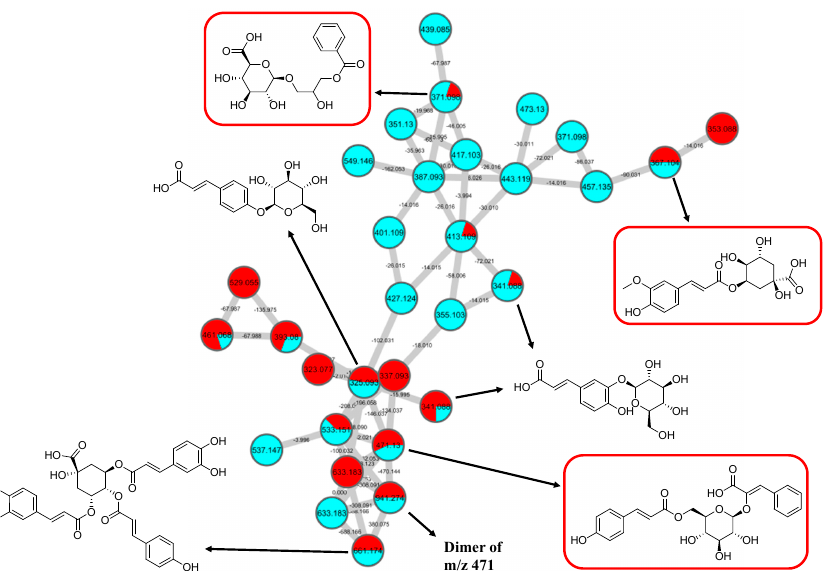
Figure 10. Hydrocinnamic acids and derivatives (cluster B in negative mode) from the full molecular network (MN) of ethyl acetate fraction of flower C. ternatea (CTF_EA) extract. The metabolites in red boxes were annotated based on the GNPS library matching.